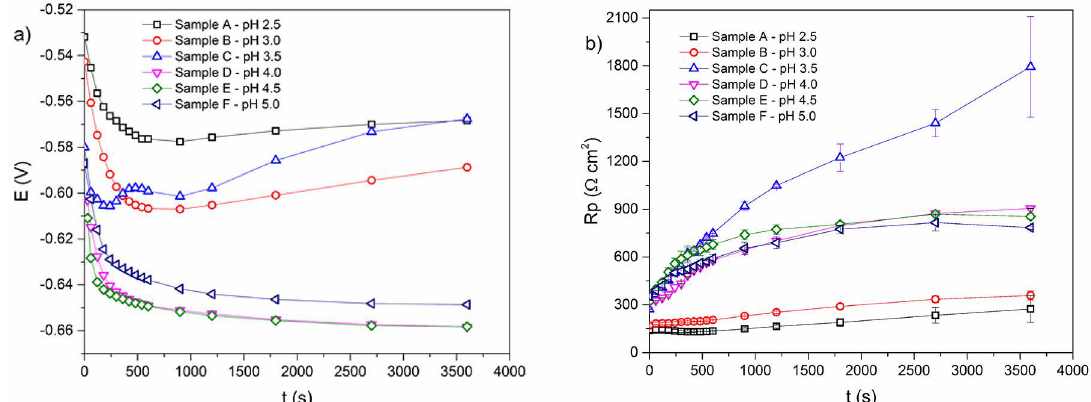
Figure 2. (a) OCP measurement and (b) polarization resistance trends of steel in treatment in hexafluorozirconic acid